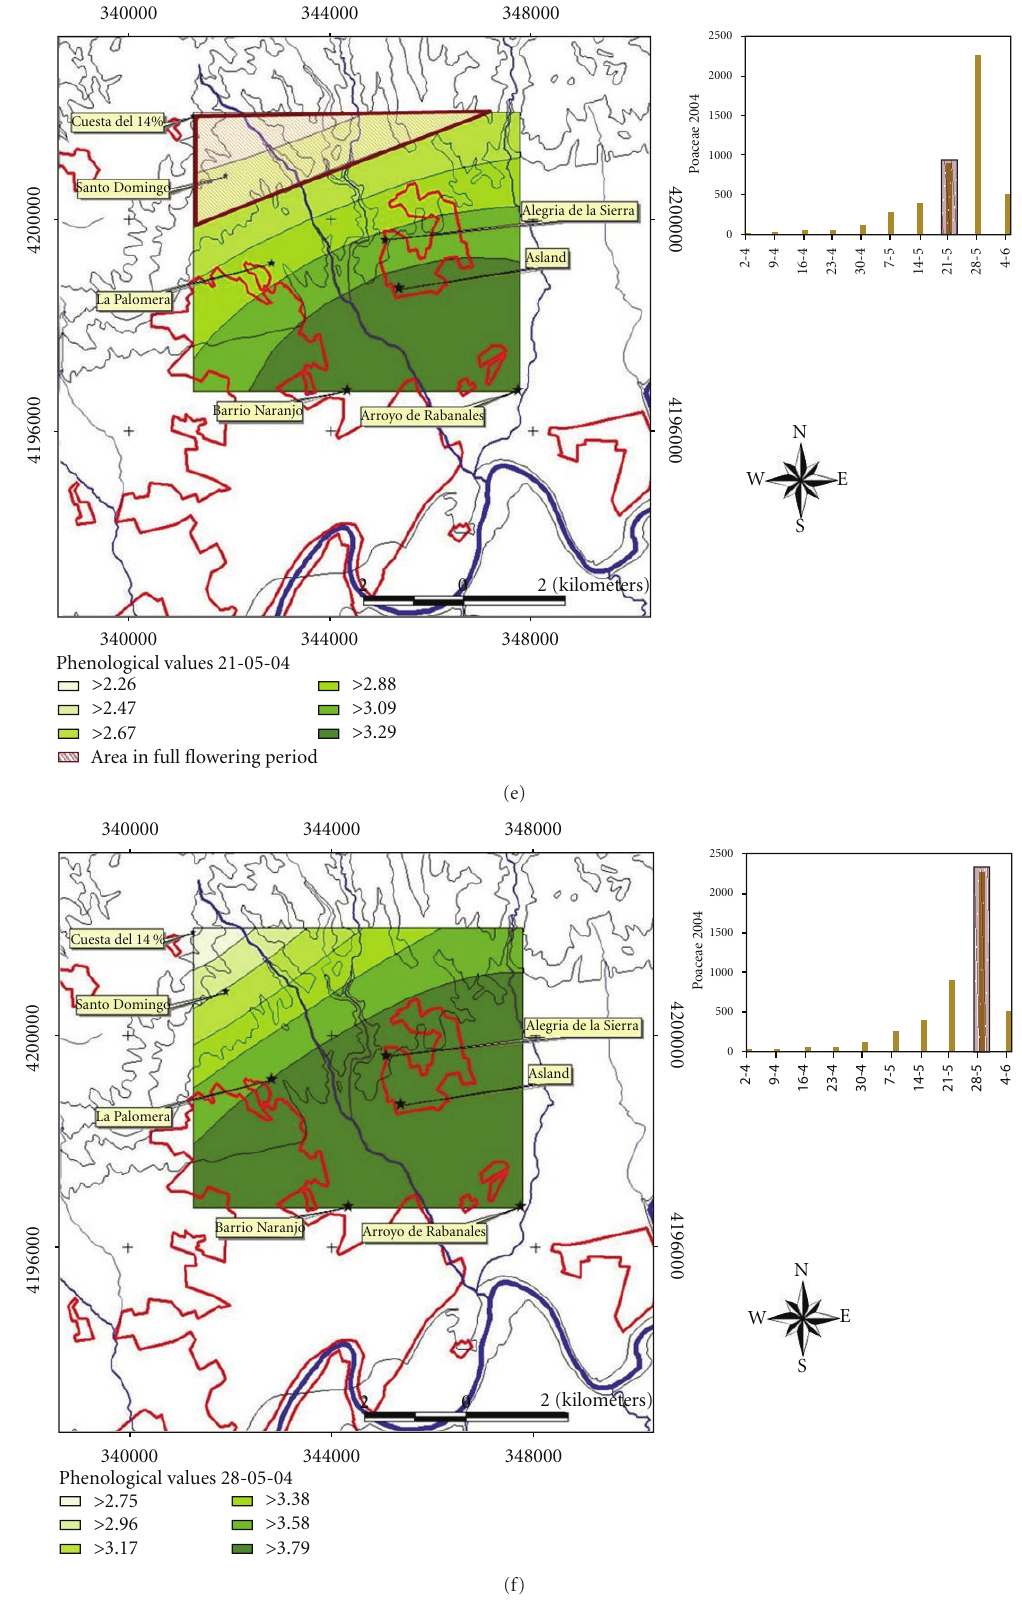
Figure 6: Phenological maps. Year